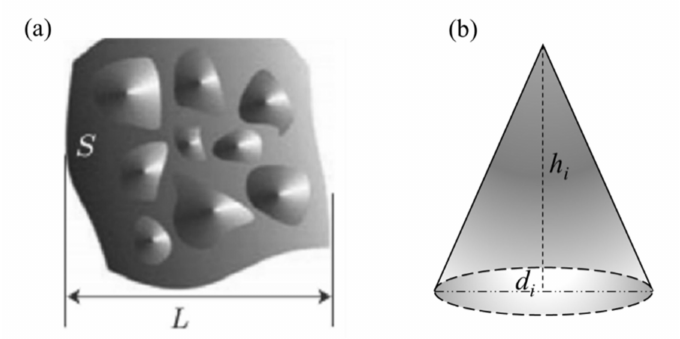
Figure 2. Typical morphology of a rough surface: ( a ) top view of a rough surface, ( b ) a representative cone-like rough